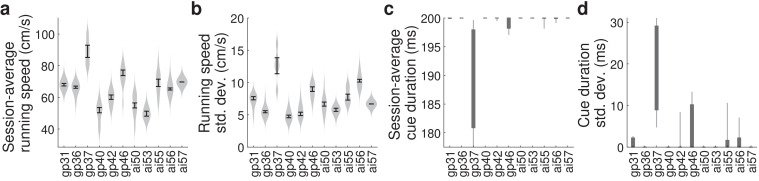
Session-specific behavioral parameters, by mouse.(a) Distribution (kernel density estimate) of session-average running speeds, for individual mice (columns). For each mouse, running speeds are sampled at the onset times of all the cues encountered in a given session, and then averaged across cue onsets for that session as a single entry in the distribution. (b) Distribution of session-specific standard deviation of running speeds, for individual mice (columns). Running speeds are computed as in (a), and then the standard deviation (instead of the mean) taken per session as a single entry in the mouse-specific distribution. (c) Session-average duration for which individual cues were visible to a given mouse (columns). The maximum duration is 200 ms after which cues were made to disappear, but shorter effective durations are possible if the mouse runs very quickly past the cue, causing it to move past the visual range of the VR display. Bars: 68% C.I. Lines: 95% C.I. (d) Session-specific standard deviation of cue visibility durations as in (c). Bars: 68% C.I. Lines: 95% C.I.